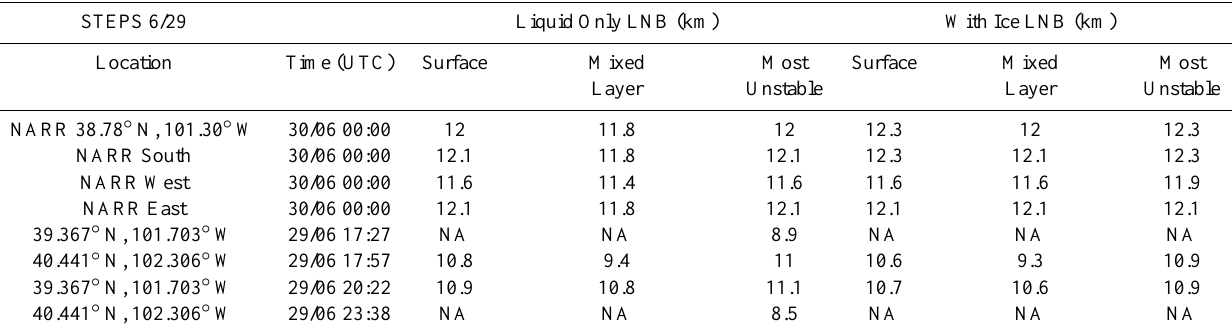
Table 2. Level of neutral buoyancy (LNB) calculated for the STEPS 6/29 case, including simulated (NARR) and observed soundings. LNB is calculated assuming irreversible (pseudoadiabatic) ascent using two methods (liquid only hydrometeors and liquid and frozen hydrometeors) and using three different initial parcel assumptions (surface-based, mixed layer, and most unstable). STEPS